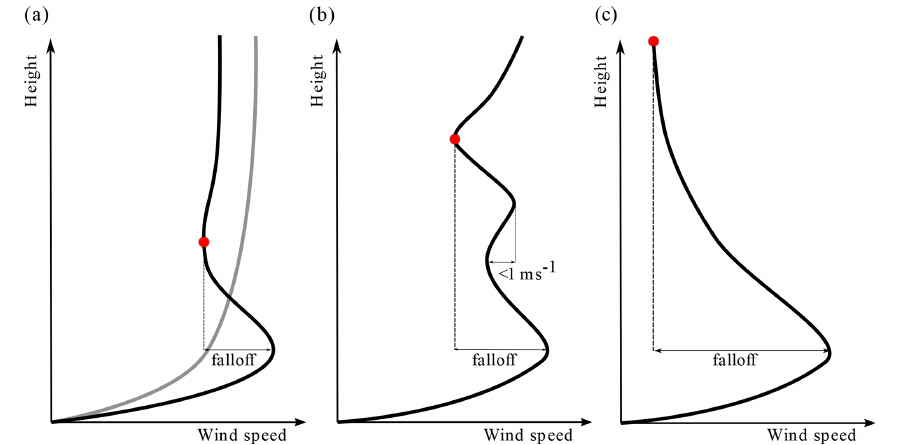
Figure 4. Schematic view of LLJ detection criteria. Red dots indicate the minimum in the wind profile used for calculating the falloff. The grey line in panel (a) represents a “standard” logarithmic wind profile. (a) A maximum on the wind profile is considered as an LLJ if it is 1ms − 1 faster than the minimum above. (b) A minimum is neglected if the wind speed upwards increases less than 1ms − 1 before decreasing again. (c) If no minimum is detected, the wind speed at the top of the profile is considered as minimum.